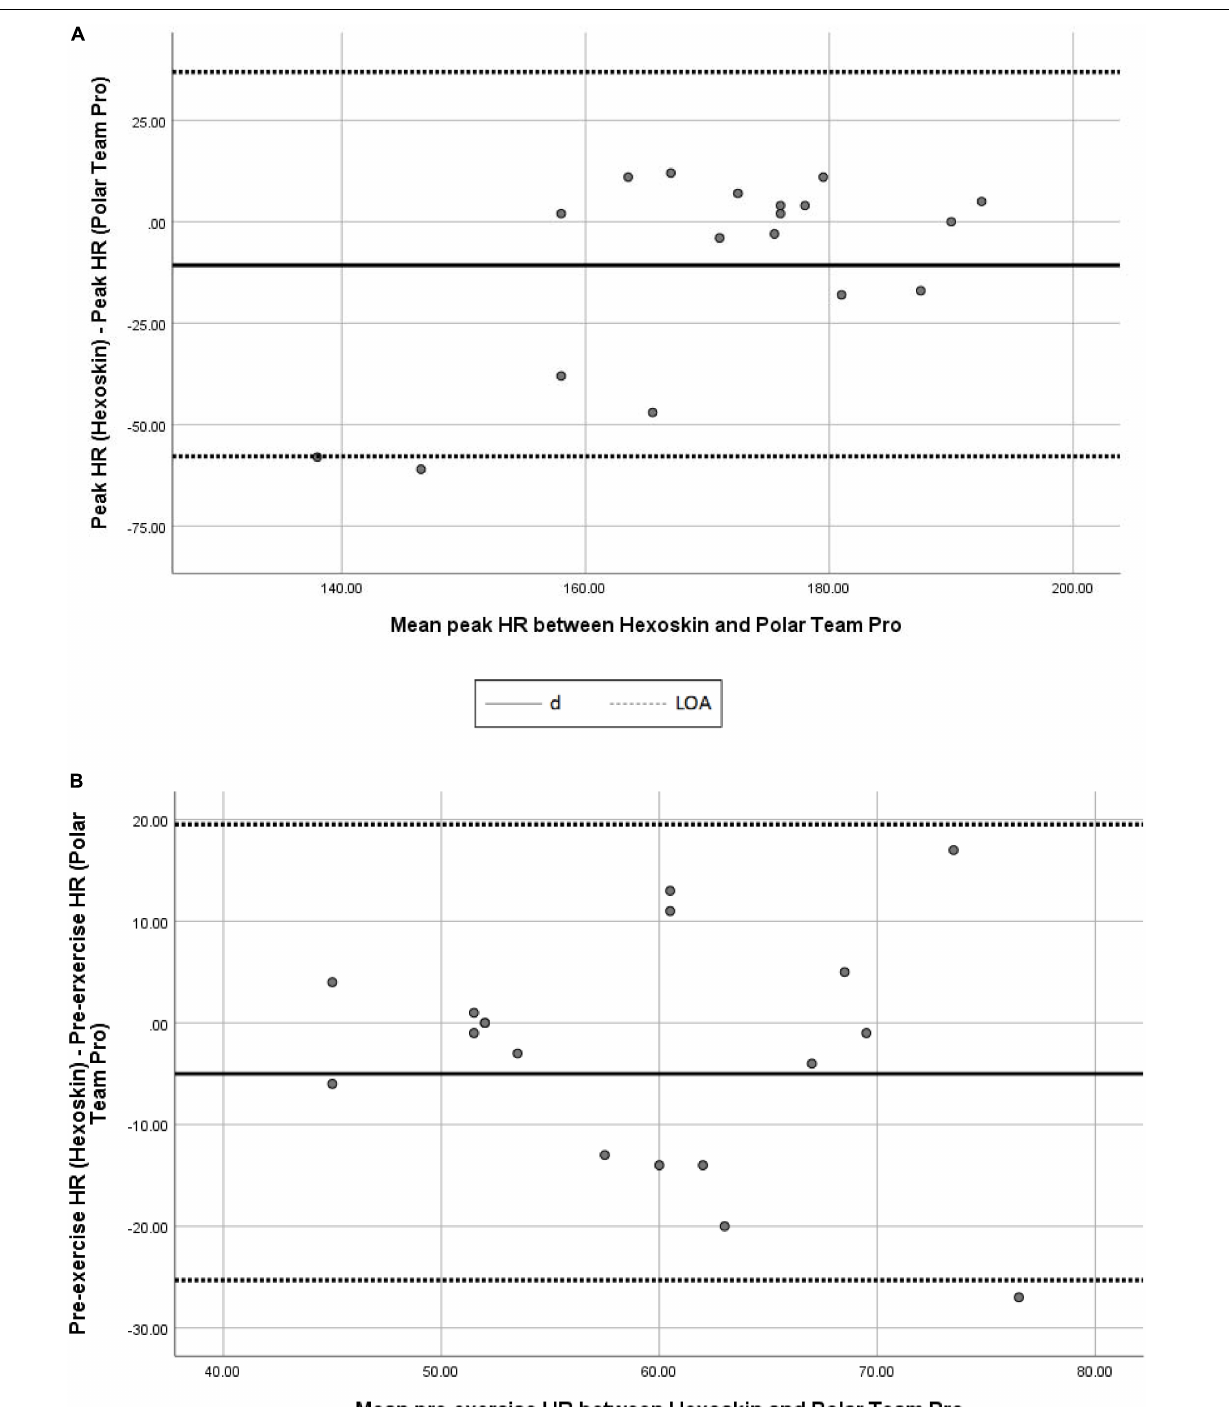
Frontiers in Physiology |